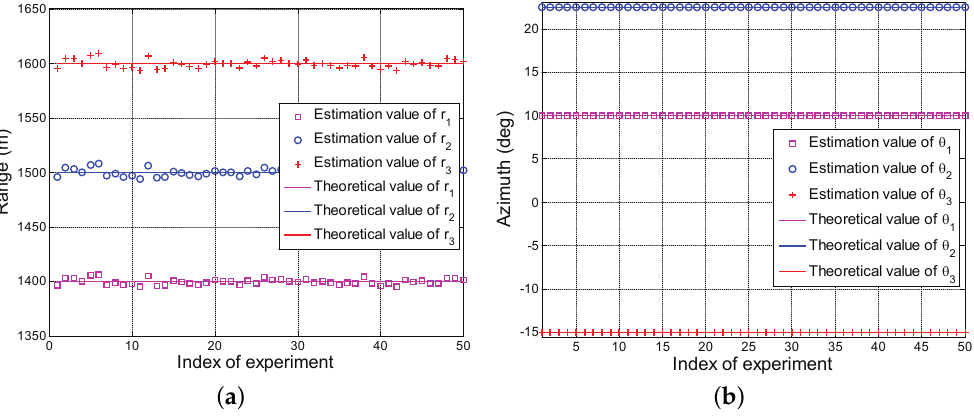
Figure 2. Average estimation values of the range and the azimuth of calibration source versus different experiments, ( a ) range; ( b ) azimuth.